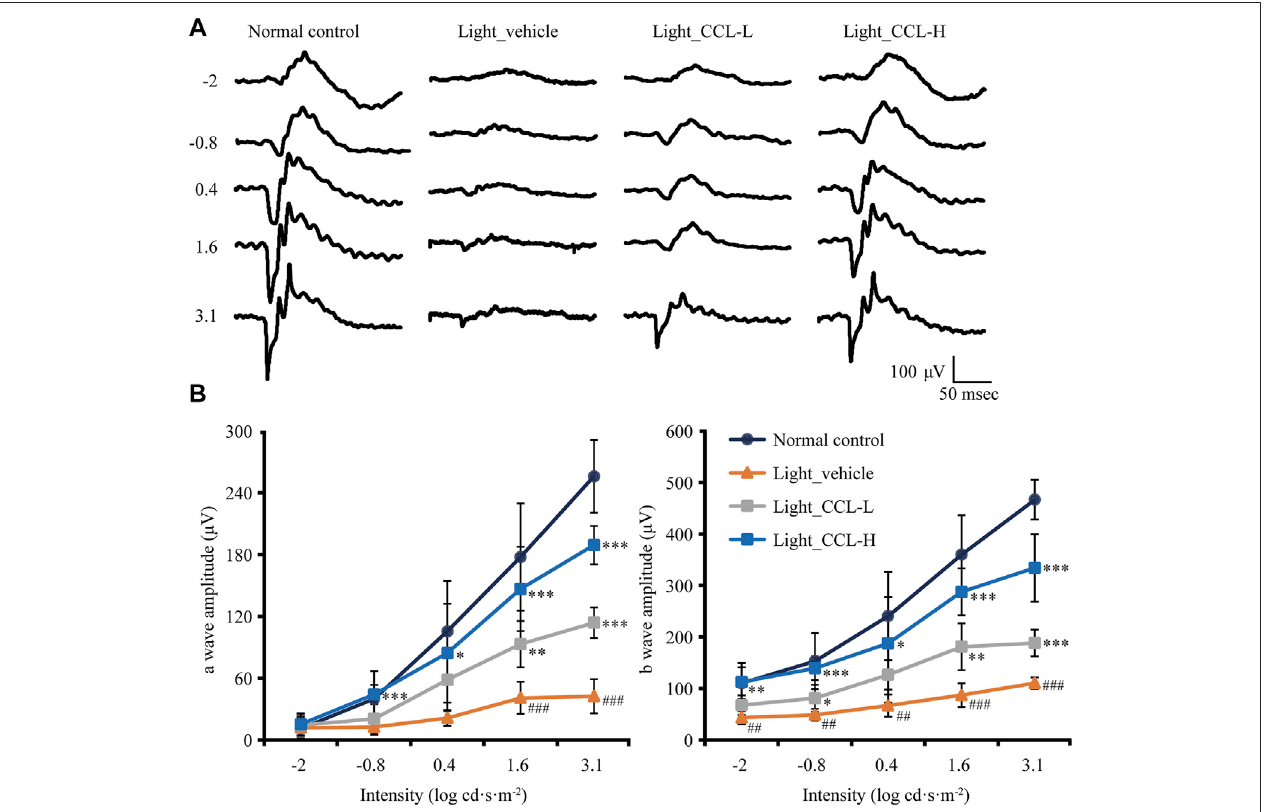
FIGURE3| CCLmaintainstheretinalfunctioninthelight-exposedmice.ScotopicERGwasperformed7 daysafterlightexposuretoassesstheretinalfunction. (A) Representativeelectroretinogramsfrom theindicatedexperimentalgroups. (B) Amplitudesofawaveandb wavewereplotted.Datawereexpressed asmean±SD(n= four to fi ve per group). # Compared to NC, p < 0.05; ## Compared toNormal control, p < 0.01; ### compared to NC, p < 0.001; *compared toLight_vehicle, p < 0.05; ** compared to Light_vehicle, p < 0.01; *** compared to Light_vehicle, p <